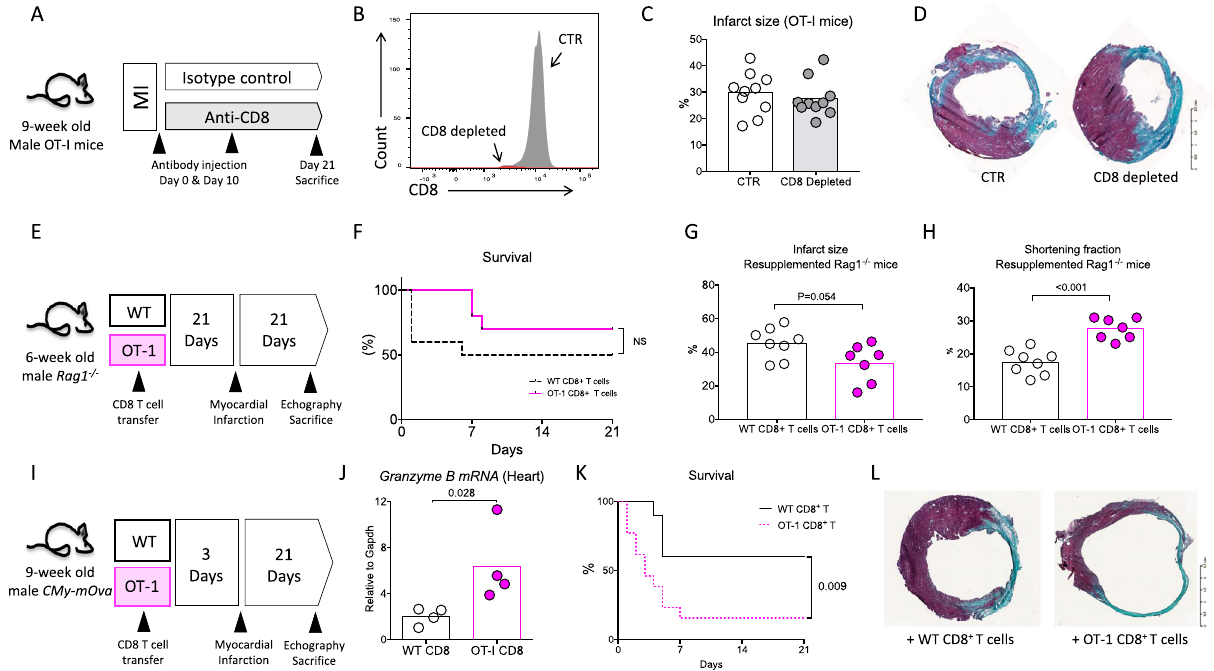
Fig. 3 CD8 + T cells pathogenic activity requires antigen-speci fi c stimulation. A Male 9-week-old OT-I mice were treated with isotype control (CTR, white) or the CD8 mAb (CD8 depleted, gray). B CD8 depletion (red) was con fi rmed in the spleen at day 21 using fl ow cytometry. C , D Representative photomicrographs and quantitative analysis of infarct size evaluation using Masson trichrome staining, in the 2 groups of OT-I mice (CTR n = 10 and CD8 depleted n = 9). E Rag1 − / − mice injected with CD8-depleted splenocytes re-supplemented with WT (white) or OT-I (pink) CD8 + T cells, 3 weeks before MI. F Survival rate following MI (from 2 experiments, WT n = 16 and OT-I n = 13). G Quantitative analysis of infarct size evaluation assessed by Masson trichrome staining in the 2 groups of mice (WT n = 8 and OT-I n = 7). H Echocardiography analysis 21 days after MI and assessment of LV shortening fraction (SF) in the 2 groups of re-supplemented mice (WT n = 8 and OT-I n = 7). I CMy-mOva mice were injected with WT (white) or OT-I (pink) CD8 + T cells, 3 days before MI. J Granzyme B mRNA expression in the ischemic heart at day 2 after MI in CMy-mOva mice injected with WT or OT-I CD8 + T cells ( n = 4/group). K Survival rate following MI (pooled 2 experiments, WT n = 10 and OT-I n = 12). L Representative examples of infarct size after Masson trichrome staining. P values were calculated using two-tailed Mann-Whitney test ( C , G , H , J ). Difference in survival was evaluated using log-rank test ( F , K